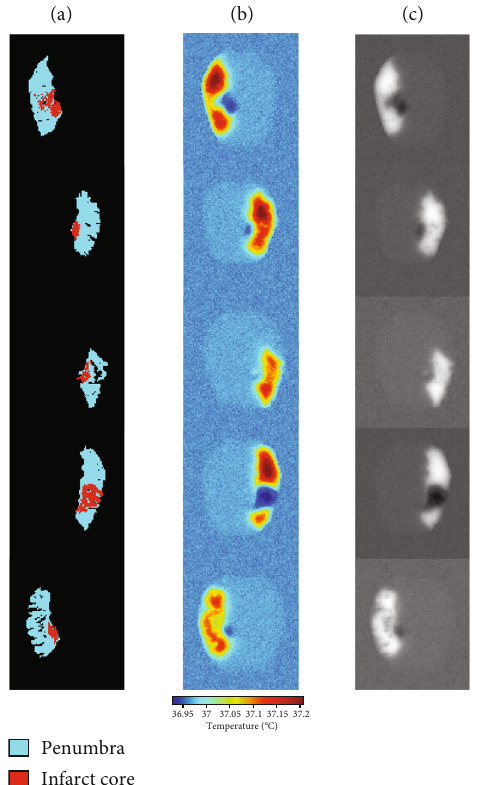
Figure 5: Thermal images taken from the dataset generated using Pennes bioheat equation of fi ve patients with acute ischemic stroke lesion of di ff erent volumes and located in di ff erent regions in the brain. (a) Ground truth of acute ischemic stroke lesion. (b) Thermal images in color. (c) Grayscale thermal images. Table 3: The segmentation evaluation metrics for U-Net segmentation in thermal images.